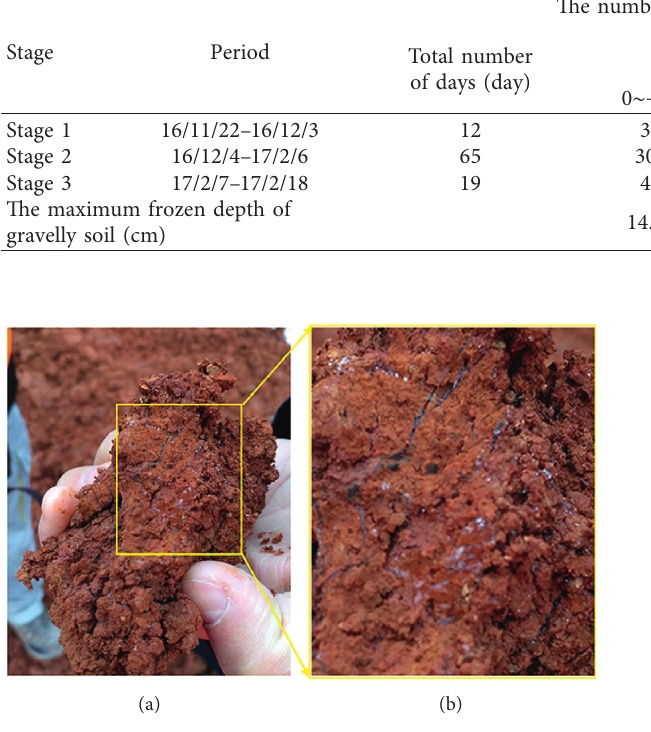
Figure 5: On-site rolling and compacting test of gravelly soil during the winter construction process (a) and the frozen soil block that is difficult to compact